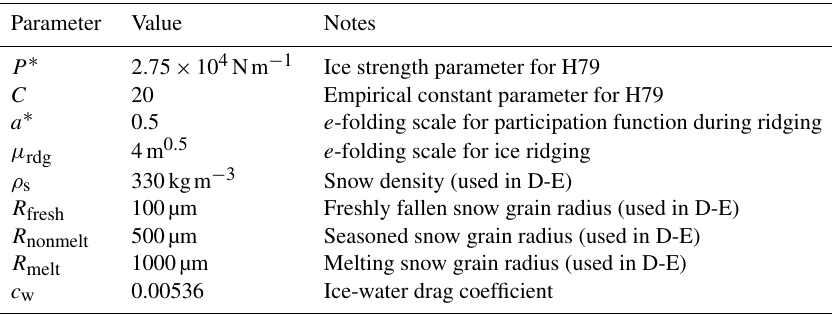
Table B1. Key model parameters of CICE in numerical